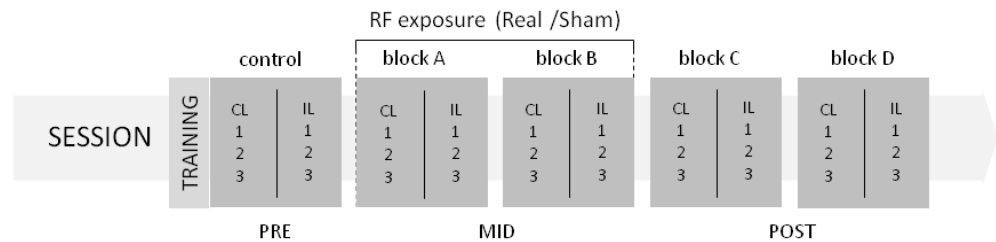
Figure 2. Timeline of the experimental design. In two sessions, each of the five consecutive blocks (control, block A, block B, block C, block D) consisted of six trials with three—three trials at the one (CL, contralateral) and at the other (IL, ipsilateral) hand. Thirty minutes after the control block (at the beginning of Block A), the half-hour exposure started: in the one session, the real (Real), and in the other the (Sham). In the last five minutes of the irradiation, the TPT data of Block B was performed. After exposure (Post) TPT’s were measured in two additional blocks (block C, block D). Half an hour passed between each block, with one minute inter stimulus intervals within one block.